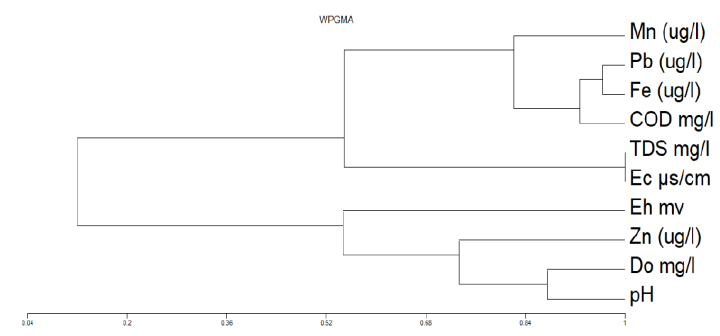
Fig. 7: The dendrogram obtained by the MVSP of Tehran rainwater after PEC treatment